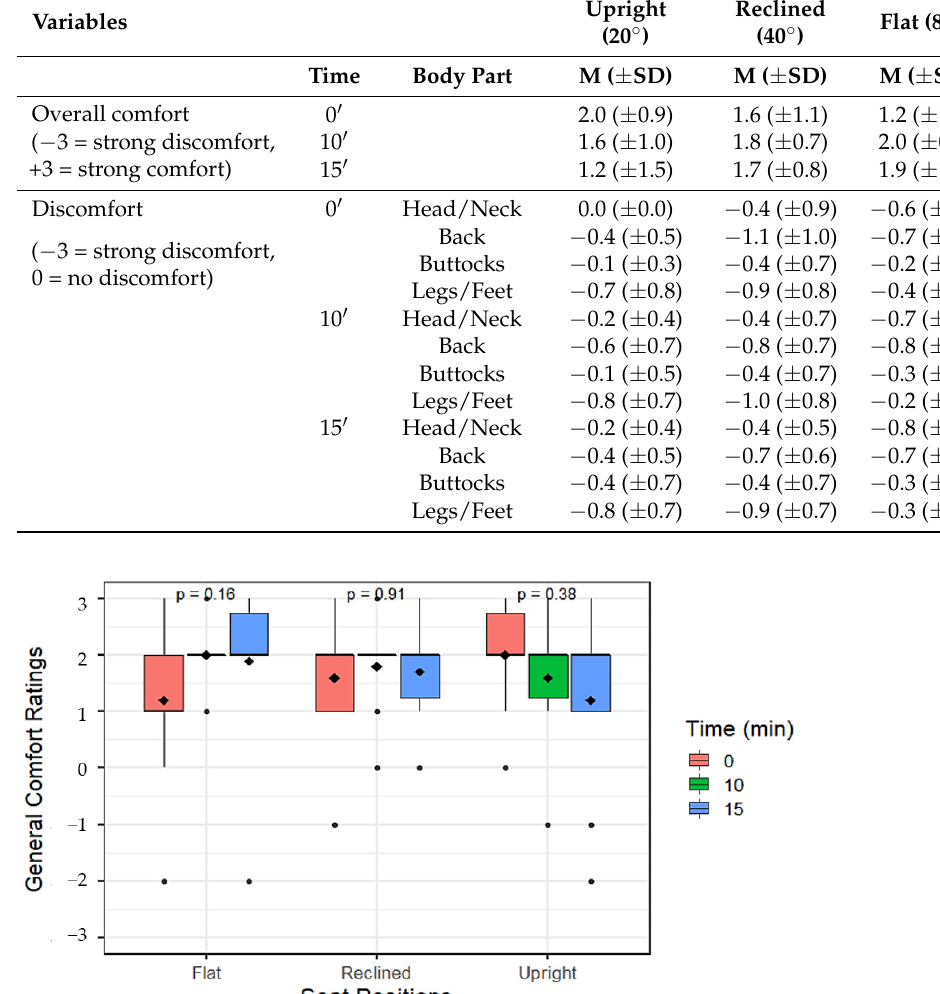
Figure 5. Boxplot with general comfort ratings for the flat, reclined and upright seat conditions over time. The diamond shapes indicate the mean and circles indicate outliers.